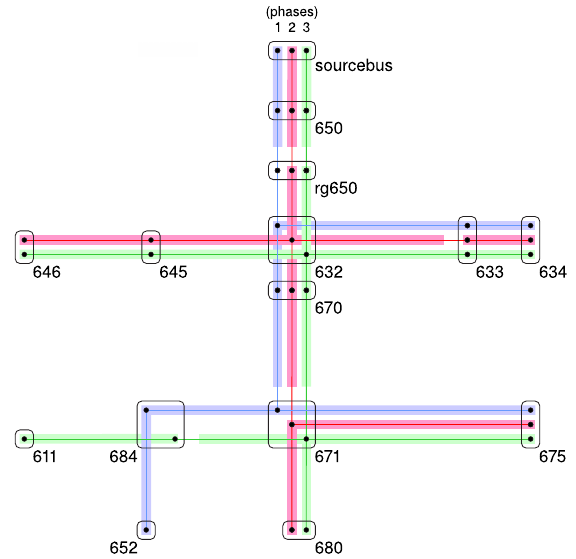
Figure 4. Phase Voltage Load Areas (ph-VLAs) with coloured bold stripes (similar results for phase Overload Load Areas